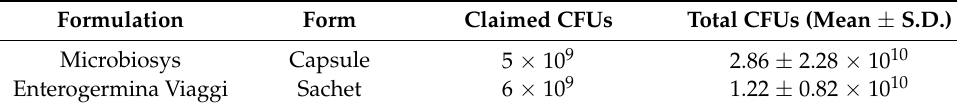
Table 1. Quantification of the microbes contained the formulations (per dose). Formulation Form Claimed CFUs Total CFUs (Mean ± S.D.) Microbiosys Capsule 5 × 10 9 2.86 ± 2.28 × 10 10 Enterogermina Viaggi Sachet